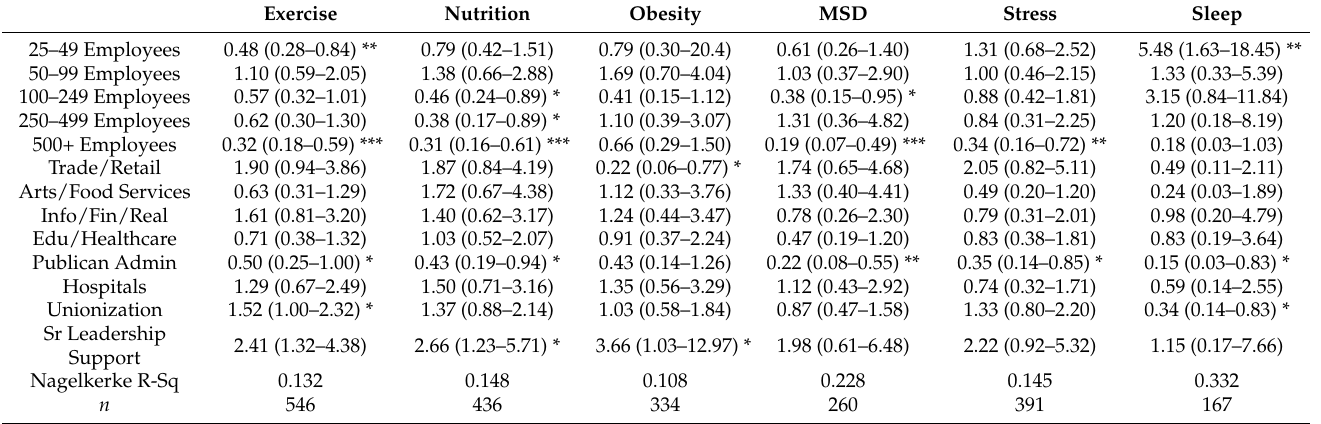
Table 5. Logistic regression with odds ratios of 25% employee participation (95% confidence inter-